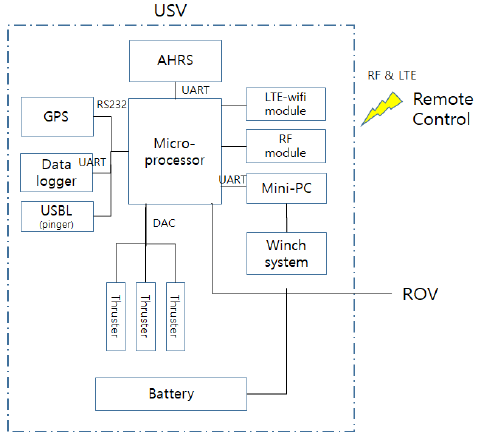
Figure 3. Control system of the USV.